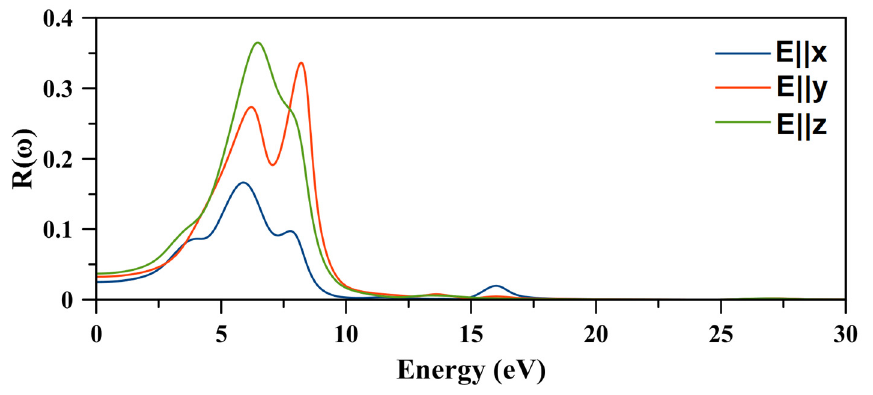
Figure 14. Variation of the optical reflectivity as a function of the energy of the (C 2 H 7 N 4 O) 2 BiCl 5 compound.